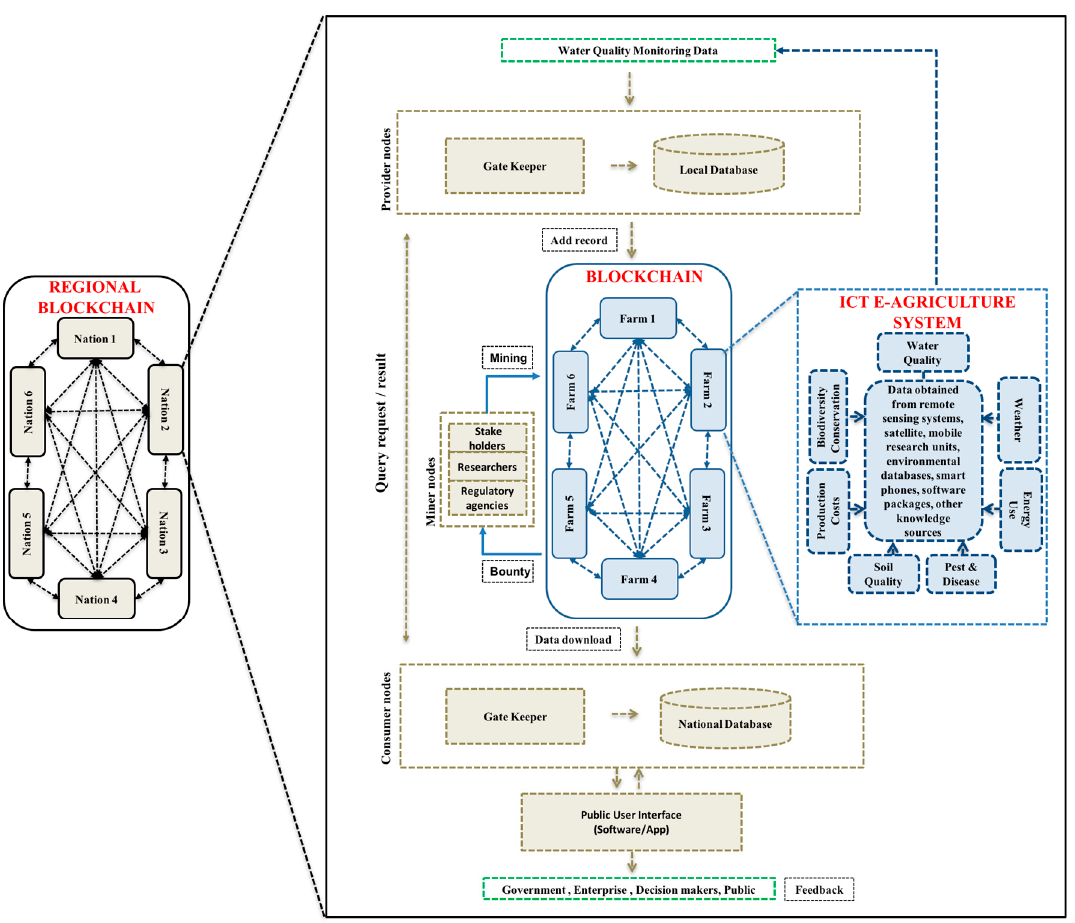
Figure 2. Information Communication Technology (ICT) e-agriculture system model with blockchain infrastructure for use at a local and regional scale.